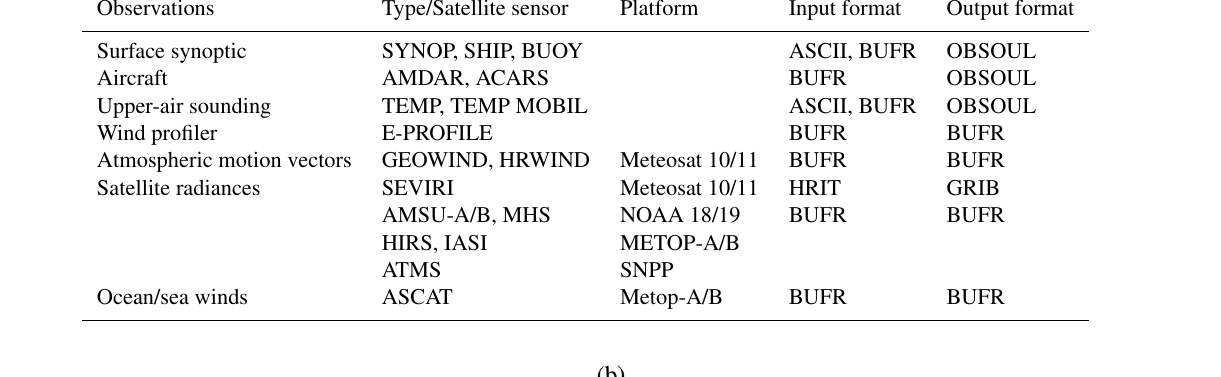
Table 1. Overview of observation types, satellite sensors and data formats available in OPLACE.